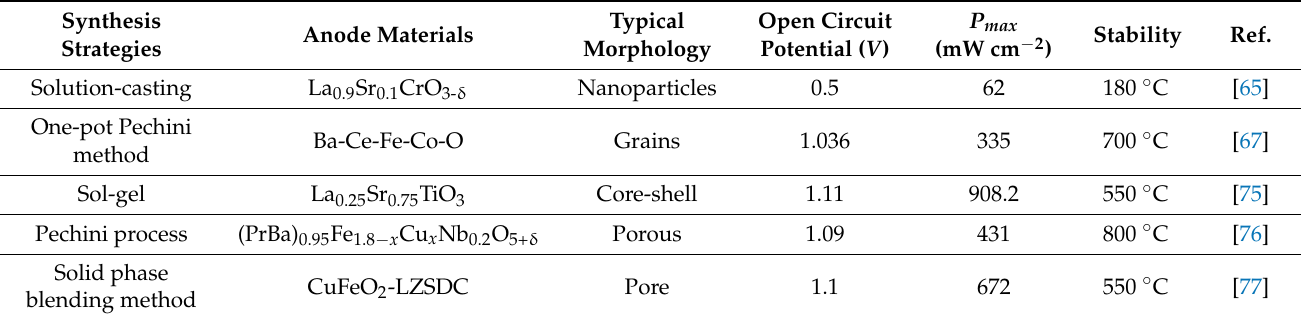
Table 2. Fuel-cell performance characteristics of different perovskite-based